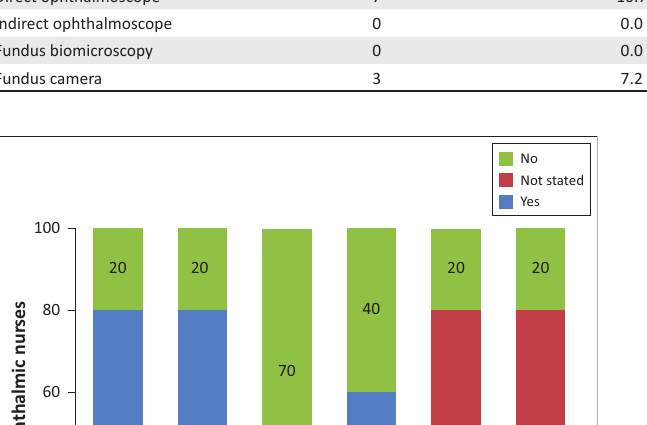
TABLE 2: Percentage distribution of equipment used by primary healthcare nurses and ophthalmic nurses to perform fundoscopy. Equipment used by primary healthcare nurses to perform fundoscopy